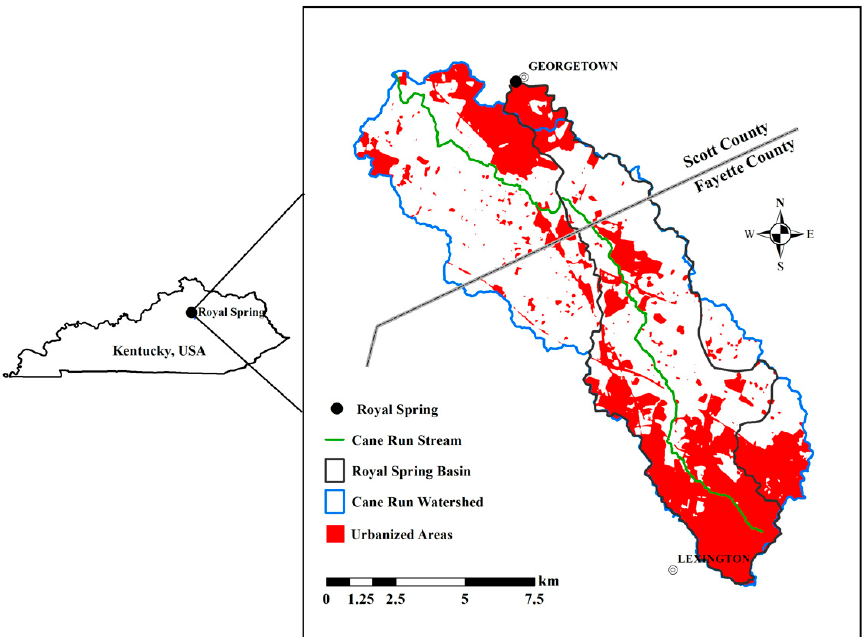
Figure 1. Locations of Royal Spring groundwater basin and field sites in this study, modified from [38].